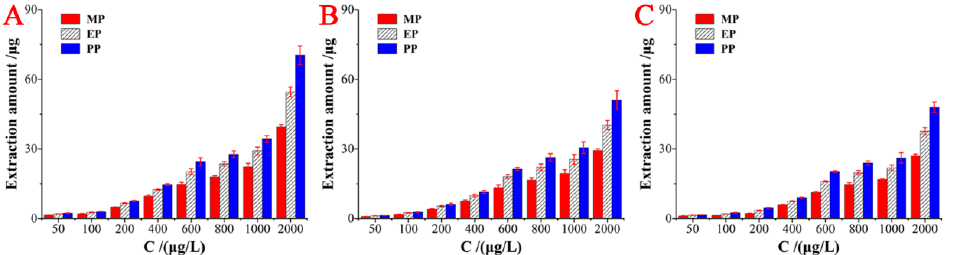
Figure 5. Extraction capacity for three analytes ( A ) SMIP fiber array; ( B ) SNIP fiber array; ( C ) AM-MIP fiber array.